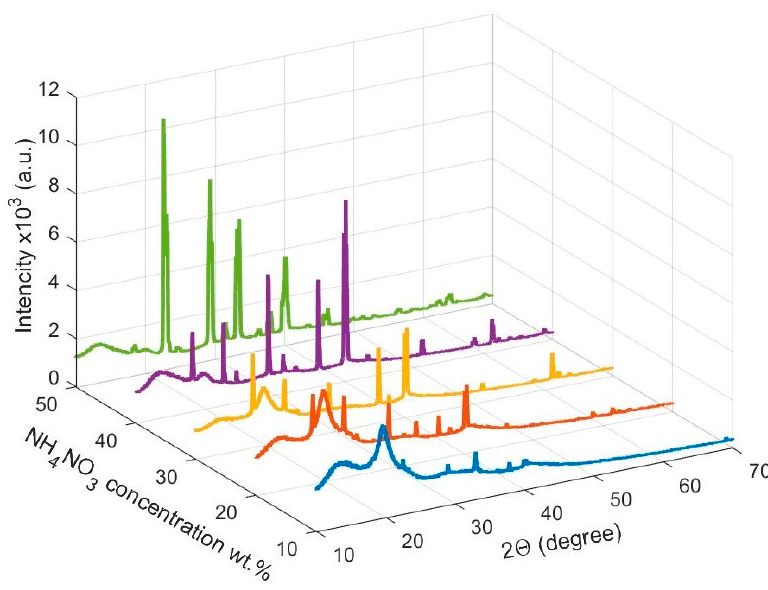
/ NH 4 NO 3 proton-conducting SPE